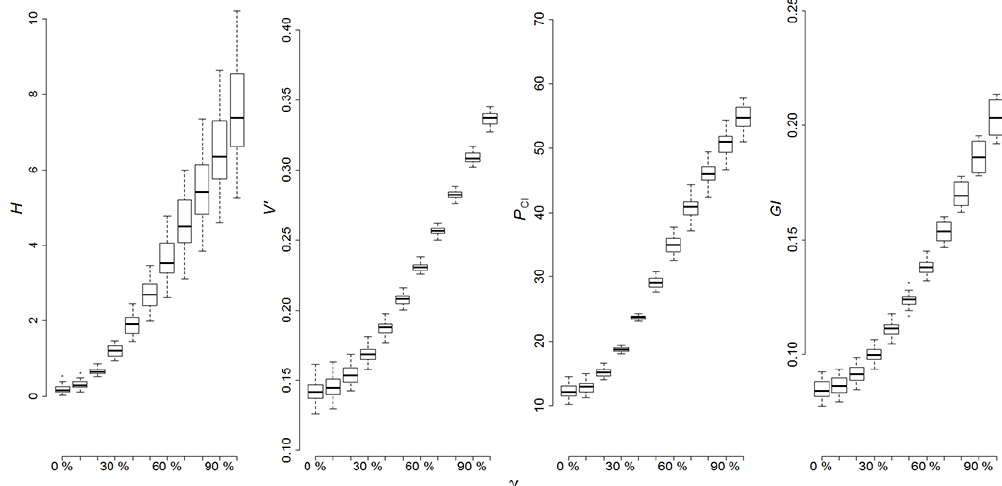
Figure 6. Box plots of representative values of the heterogeneity measure average obtained for 22 cases, varying the heterogeneity rate γ in the x axis. For each case, such a representative value is obtained as the average between a given region A and a given region B over N s = 500 simulations of the given regions, entailing the same γ (i.e. γ A = γ B ) but different characteristics (i.e. N A (cid:54)= N B or N A = N B with τ A (cid:54)= τ B